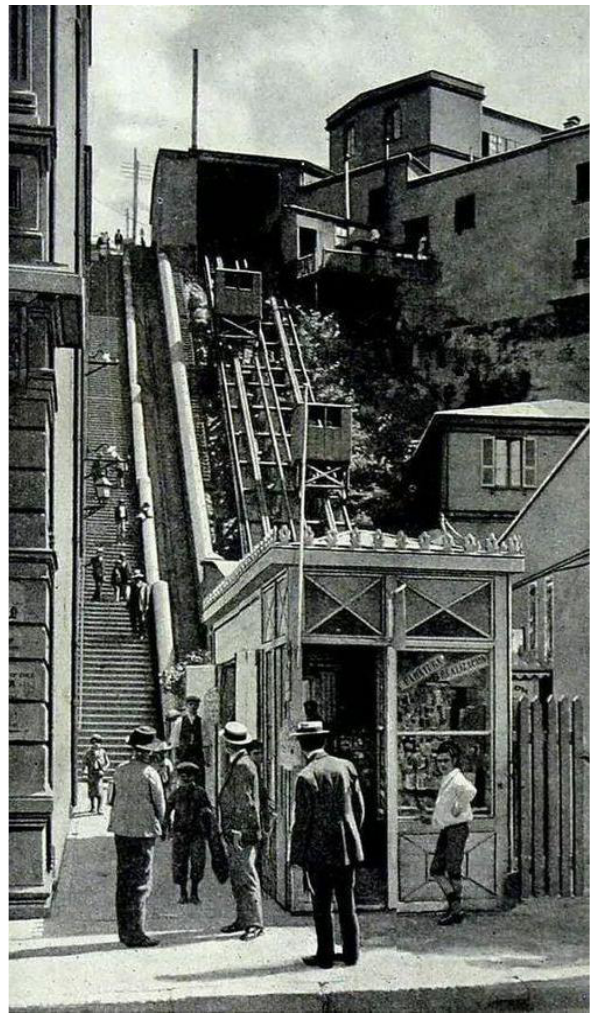
Figure 4. Cordillera elevator. 1910